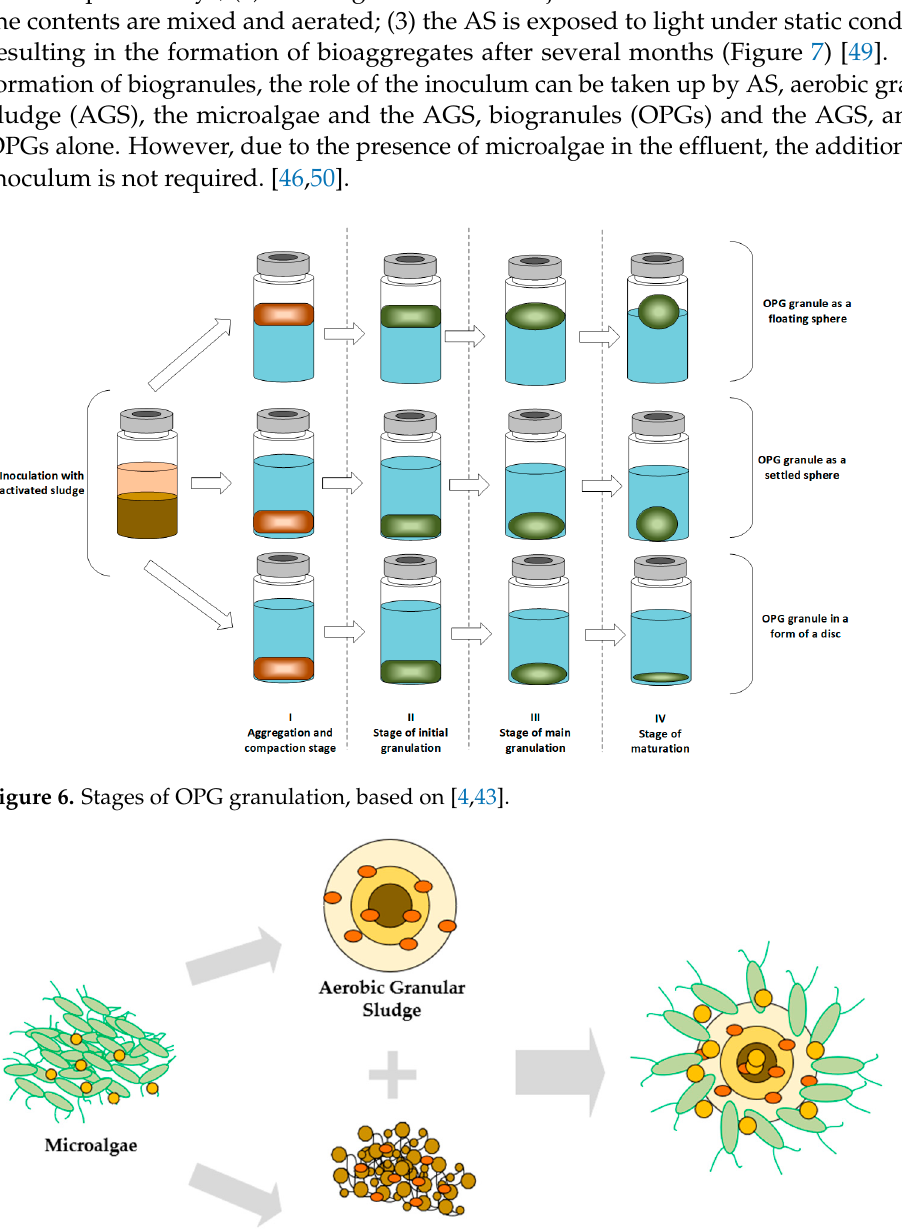
Figure 7. Strategies for breeding biogranules, based on [46,49] .